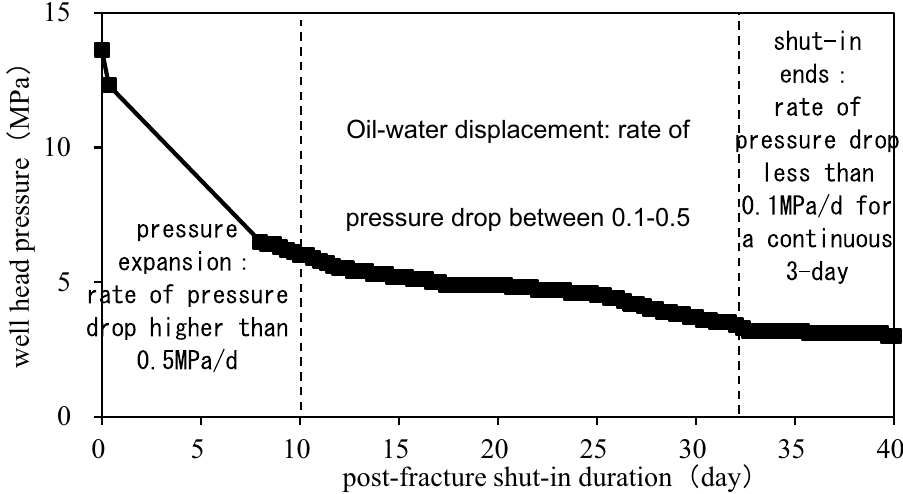
Figure 5. Division of well shut-in stages using wellhead pressure drop.